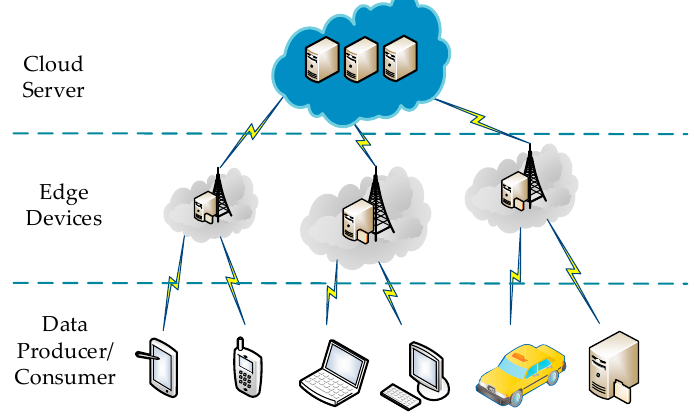
Figure 1. The structure of edge network.